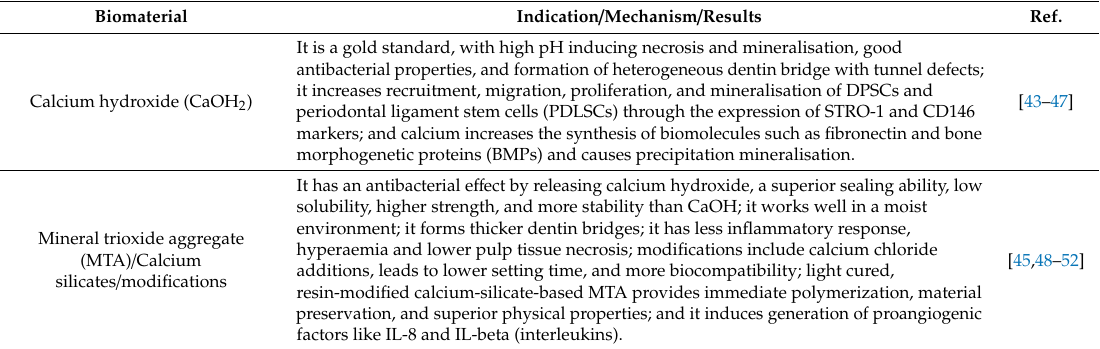
Table 3. Cell-free therapies for dentin and pulp